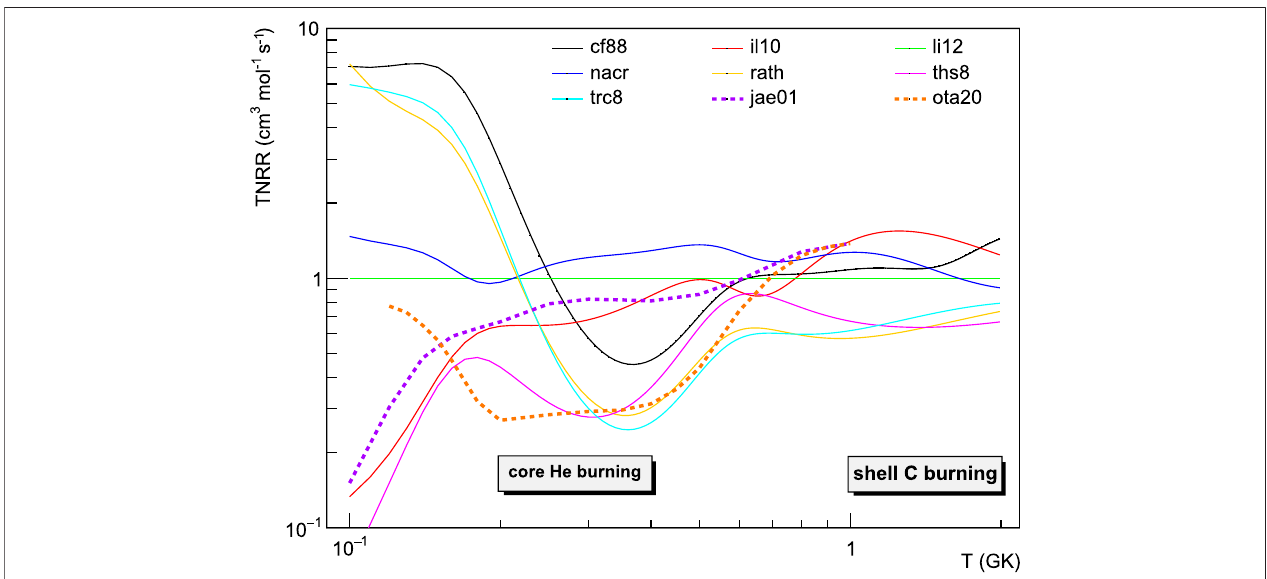
FIGURE 7 | A subset of the 22 Ne( α ,n) 25 Mg reaction rate evaluations, relative to Longland et al. (2012). Solid lines refer to the evaluations reported in the JINA REACLIBdatabaseasinCyburtetal.(2010).Inparticular,cf88 (cid:2) CaughlanandFowler(1988);nacr (cid:2) Anguloetal.(1999);rath (cid:2) RauscherandThielemann(2000);ths8 (cid:2) Cyburt et al.(2010); il10 (cid:2) Iliadis et al.(2010);trc8 (cid:2) REFIT: Cyburt etal.(2010);li12 (cid:2) Longland et al.(2012).Dashed lines: jae01 (cid:2) Jaeger etal.(2001);ota20 (cid:2) Otaet al. (2020).